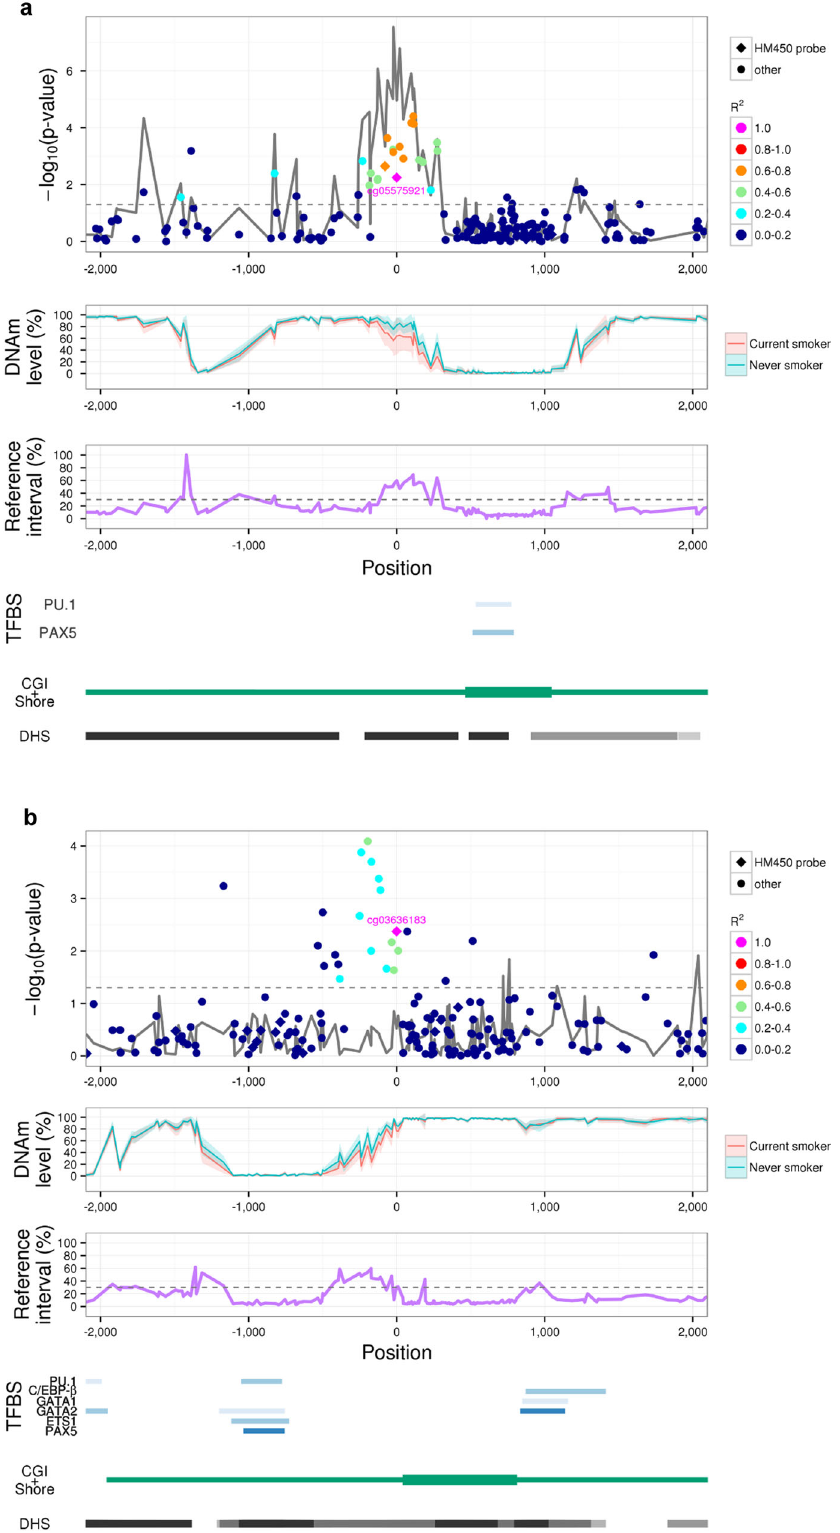
(Fig. 6a, c, e). Histone marks for (active and inactive) enhancers (H3K4me1; 15.6%) showed similar or slightly broader reference intervals (Fig. 6e). In CD4 + T cells, similar tendencies were observed (Fig. 6g –